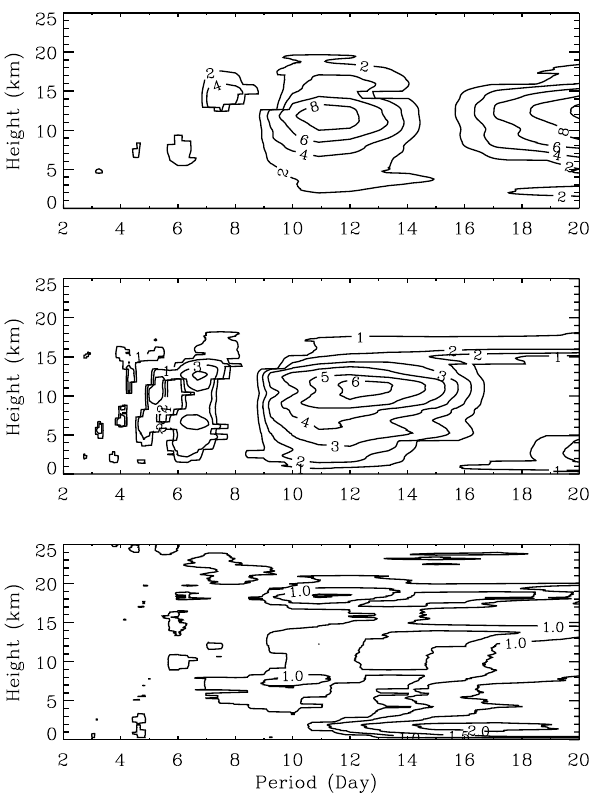
Fig. 9. Lomb-Scargle periodograms of zonal wind (top), merid- ional wind (middle) and temperature (bottom) disturbances in Au- gust 2006. Only the values with confidence levels greater than 95% are shown. The minimum value and the interval of the contours for the zonal wind are all 2ms − 1 , for the meridional wind are all 1ms − 1 , and for the temperature are all 0.5K.